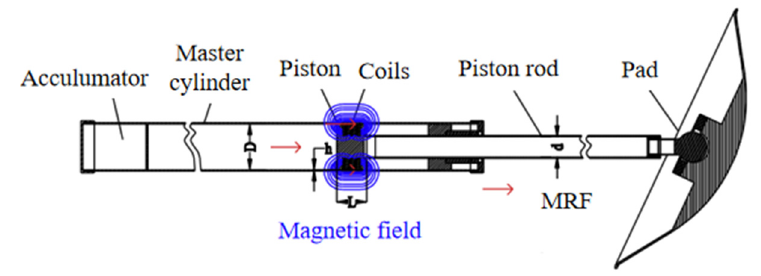
Figure 18. New lunar lander with MRD [111].